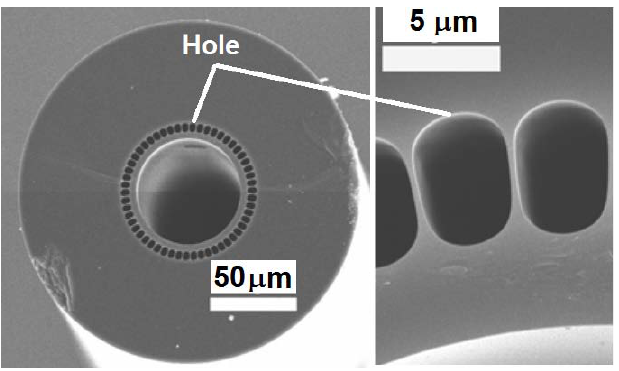
Figure 19. SEM images of the fiber (left) and of the narrow silica bridges forming the air-clad (right) [117].